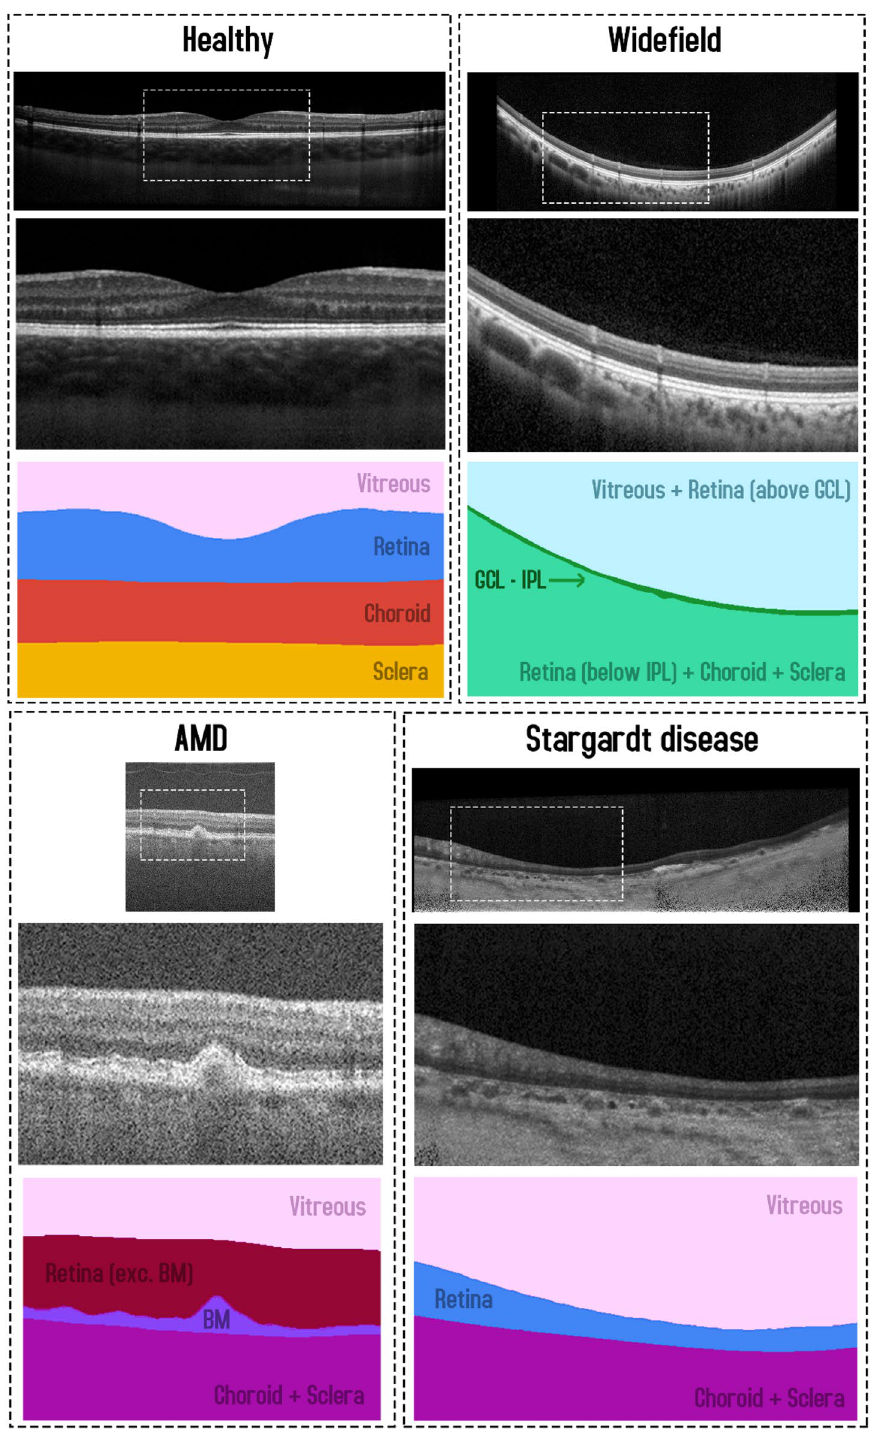
Figure 1. Example OCT image and corresponding semantic segmentation mask for each of the four datasets. Images are shown maintaining their aspect ratio. Each individual colour corresponds to a different region/class as labelled. White dashed box in the topmost corresponds to the zoomed region (second and third images) for each